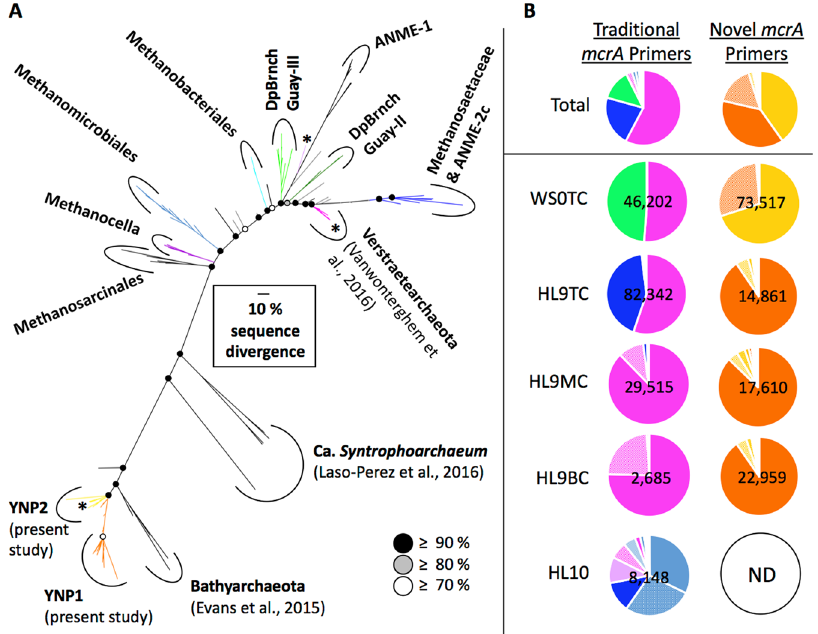
Figure 4. Phylogeny and occurrence of Bathyarchaeota-like (orange and yellow), verstraetearchaeotal (pink), and euryarchaeotal (other colors) McrA proteins. ( A ) Bayesian analysis of McrA phylogeny based on 150 amino acid positions. Heavy weighted branches indicate sequences recovered in the present study. Asterisks denote mcr A OTUs that were also recovered as RNA transcripts. Posterior probabilities are indicated by black, grey, or white circles at each node corresponding to ≥ 90%, ≥ 80%, and ≥ 70%, respectively. ( B ) Site specific relative abundance of mcrA OTUs produced by traditional and newly designed primer sets. Following the sample IDs, the designations “TC”, “MC”, and “BC” stand for “top core”, “middle core”, and “bottom core”, respectively. Total sequence number for each sample is given for each pie chart. No mcr A genes were amplified from HL10 with newly designed primers (ND = not determined). DpBrnchGuay = deeply-branching Guaymas group. The scale bar corresponds to 0.1 amino acid substitutions per